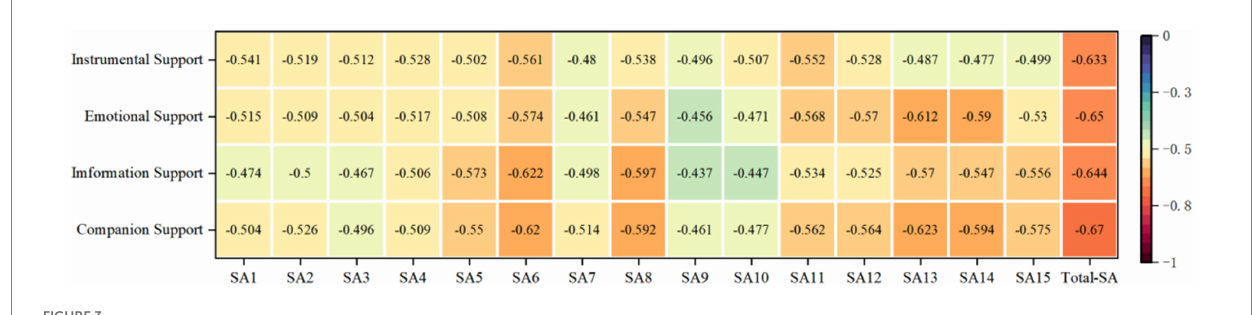
FIGURE 3 Results of correlation analysis between online social support and social anxiety.